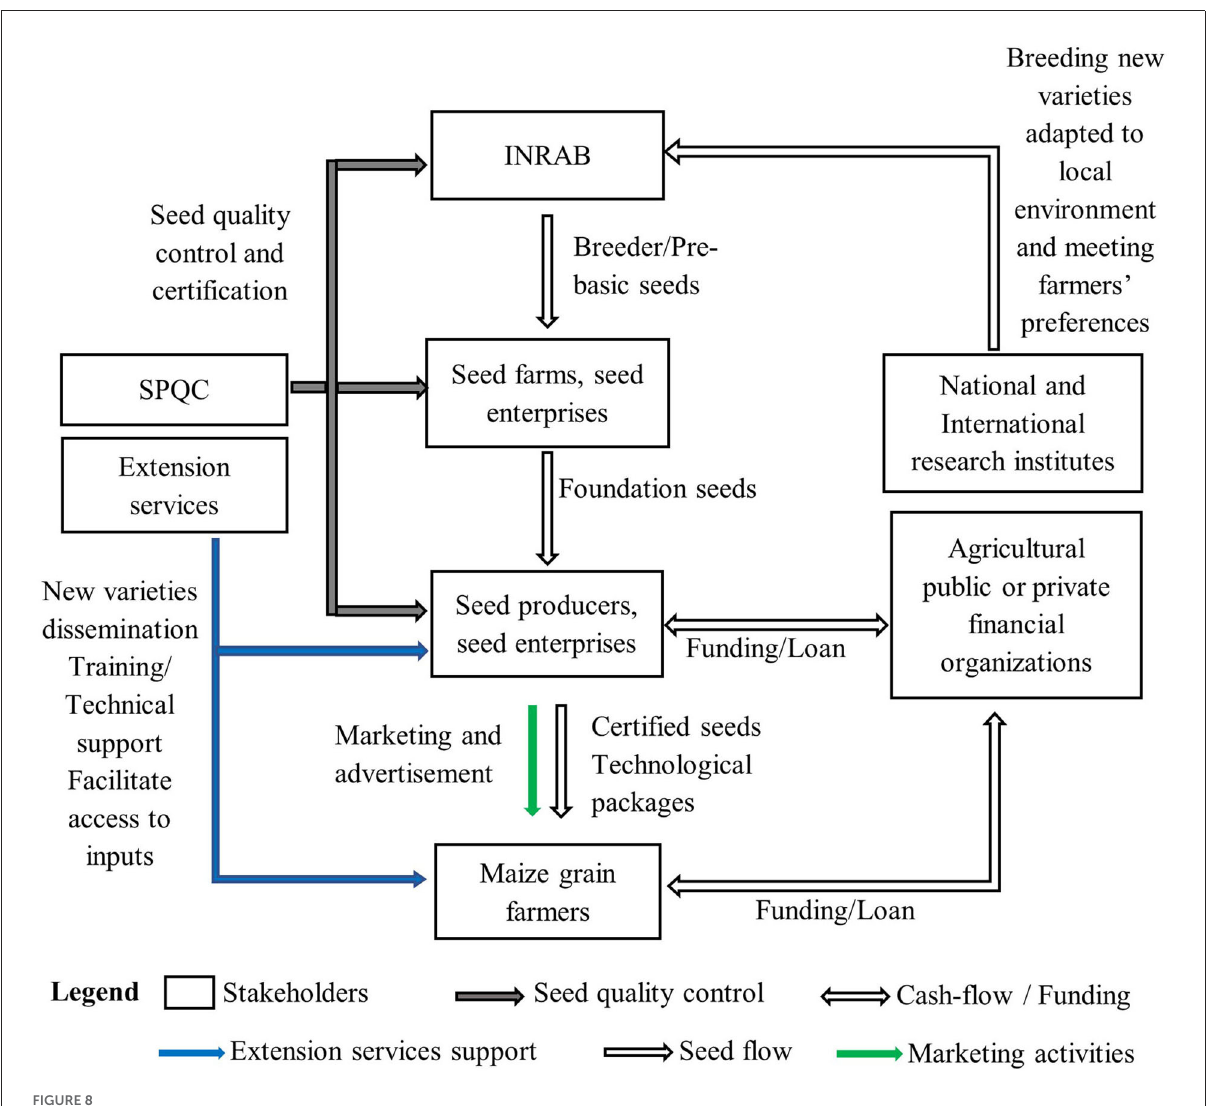
FIGURE8 Alternative scheme for an effective formal maize seed system in